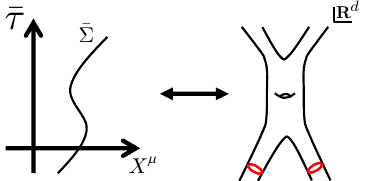
Fig. 1 ApathandaRiemannsurface. Thelineontheleftisatrajectory in the path integral. The trajectory parametrized by ¯ τ from ¯ τ = −∞ to ¯ τ = ∞ , represents a Riemann surface with fixed punctures in R d on the